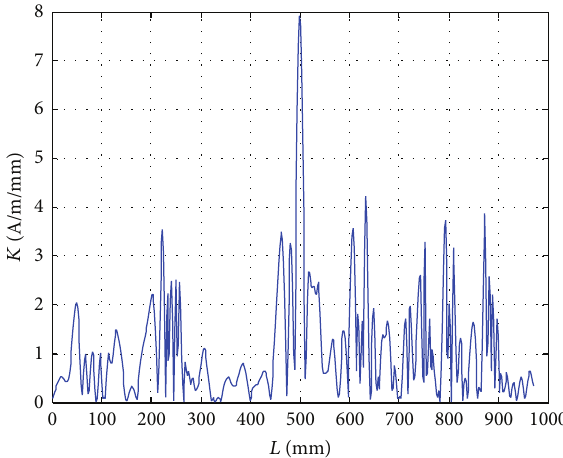
Figure 8: MMM gradient value after adaptive denoising.